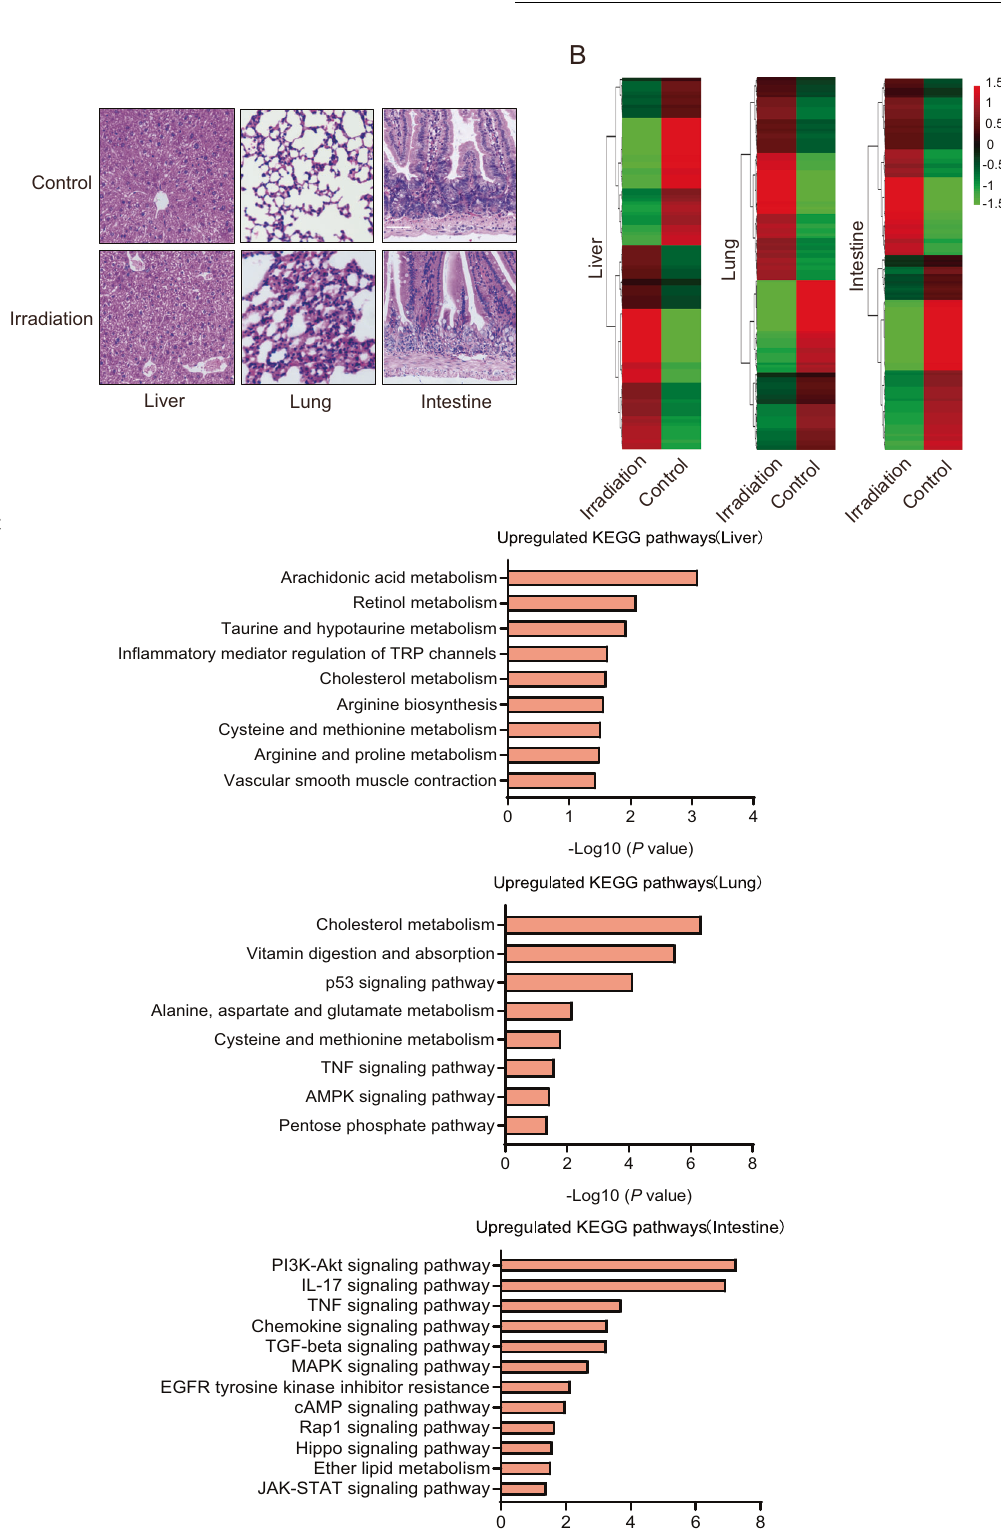
Fig. 1 The effect of IR on transcriptome of liver, lung, and intestine of mice. A Representative images of the hematoxylin and eosin (H&E) staining of the liver, lung, and intestine from control and irradiated (IR) mice. The scale bar is 50 μ m. B Changes of RNA transcription pro fi les in the liver, lung, and intestine tissues of the mice in the control group and IR group. Green bars represent down-regulation of gene expression and red bars represent up-regulation of gene expression. C KEGG Biological Process analyses differentially expressed genes in the liver, lung, and intestine of